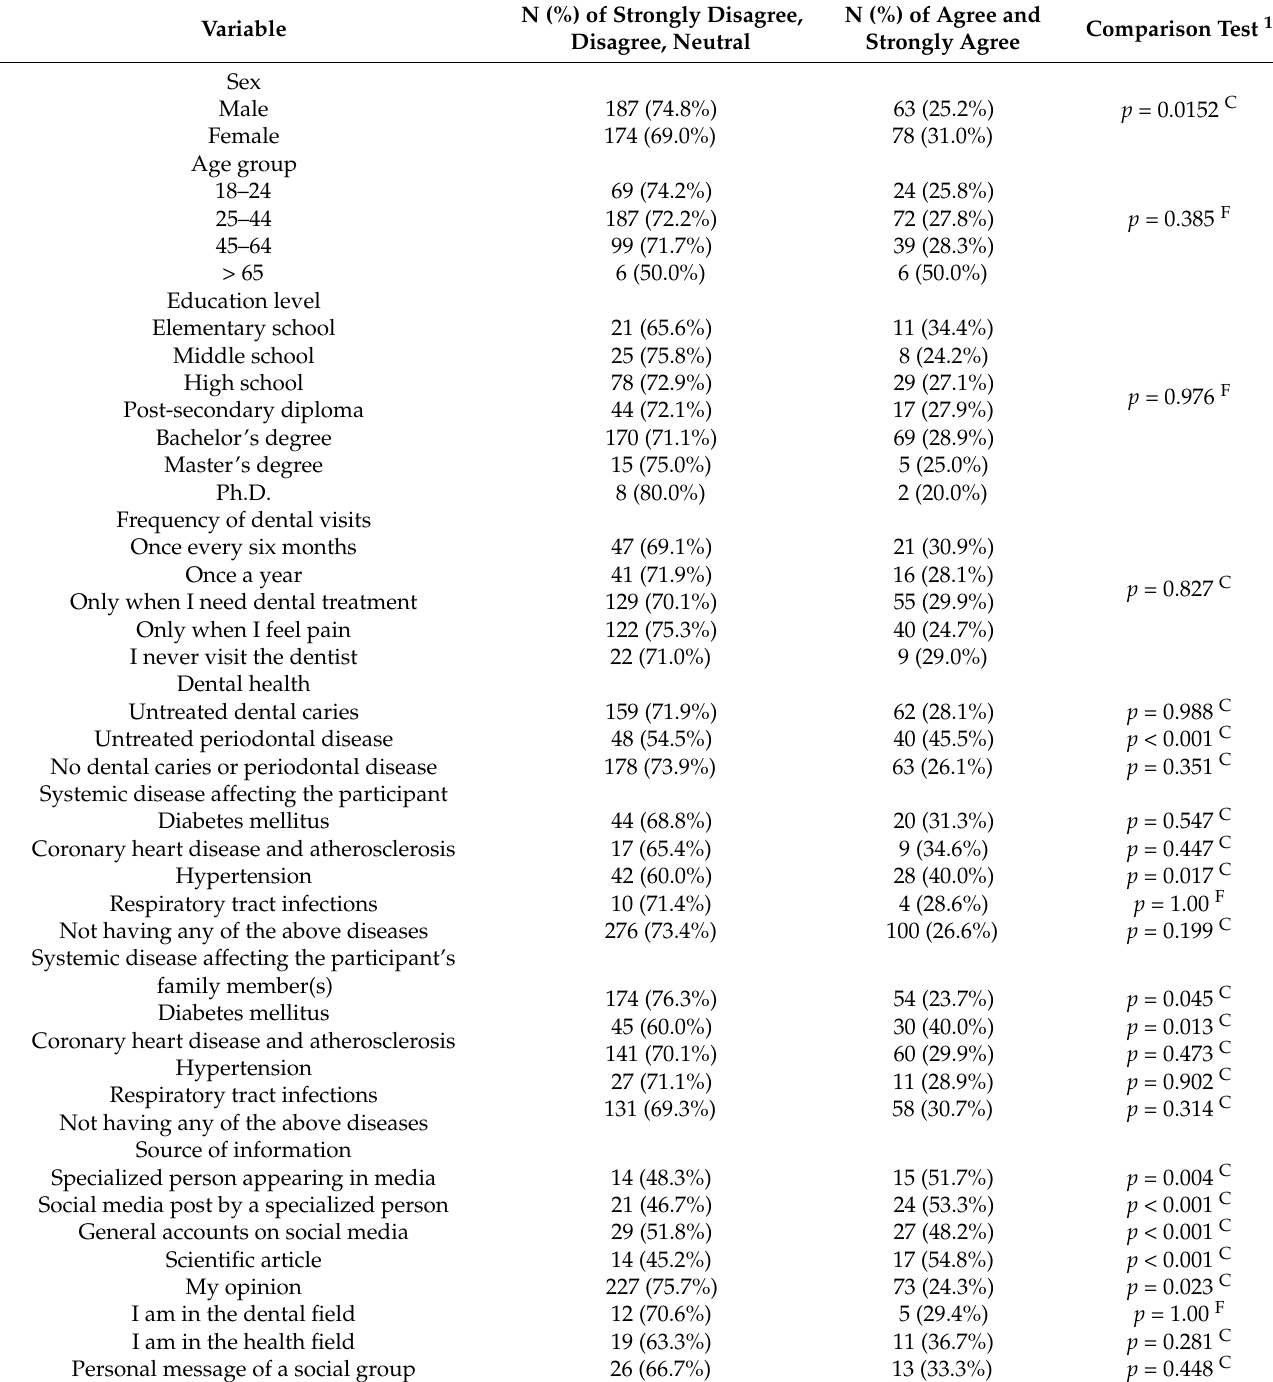
Table 12. Awareness about the association between periodontal disease and hypertension distributed by various